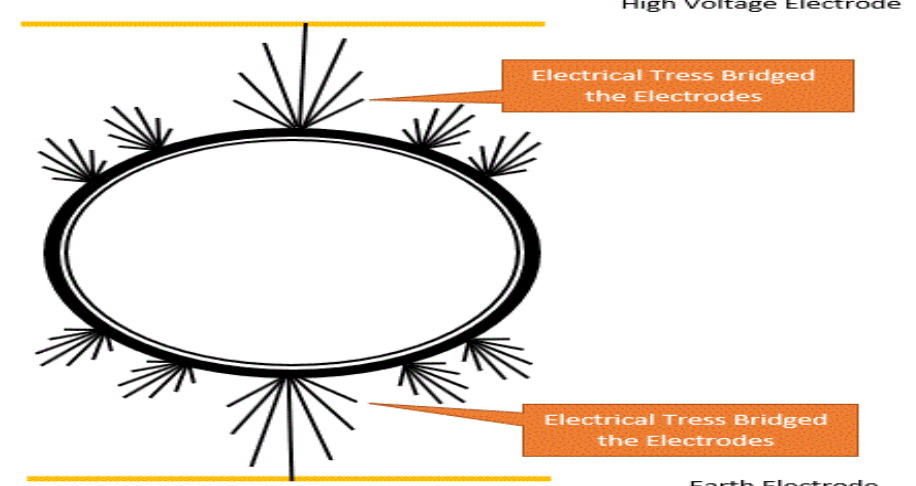
Figure 13. Discharges across an insulator to the ground.